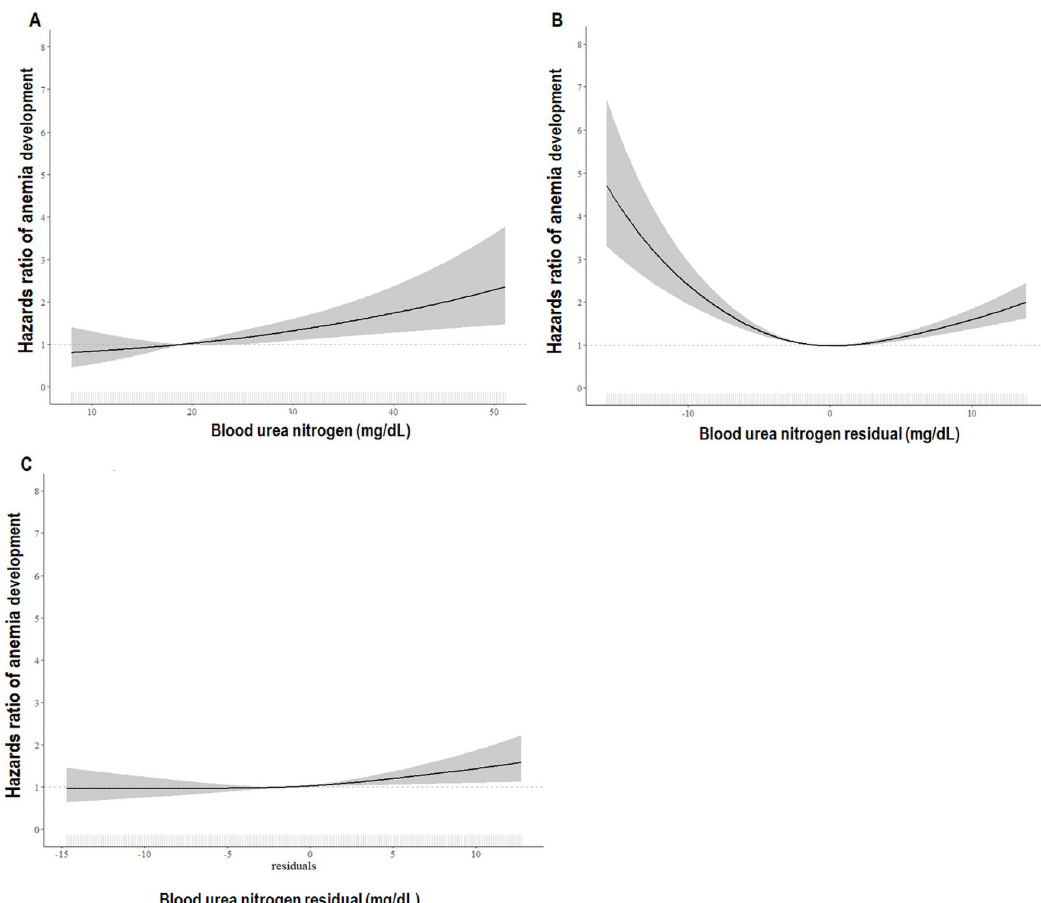
Fig 4. HRs of anemia development according to BUN and BUN residual. 4A. Multivariable-adjusted HRs of anemia development according to BUN. A restricted cubic spline curve adjusted by all confounding variables shows almost a linear positive relationship between BUN and the risk of anemia development. The adjusted HR of anemia development was significantly higher at BUN levels > 19 mg/dL. Adjusted for BUN, age, sex, smoking, SBP, DM, HTN, CCI, eGFR, log UPCR, WBC, platelet, log CRP, albumin, total cholesterol, log ferritin, log hepcidin, iron, and TSAT, use of iron replacement therapy, ESA, ACEi or ARB, statin, and diuretics. 4B. Unadjusted HRs of anemia development according to the BUN residual. Consistent with the Kaplan-Meier curve, the unadjusted cubic spline curve shows a U-shaped relationship between the BUN residual and HR of anemia development. 4C. Multivariable- adjusted HRs of anemia development according to the BUN residual. A restricted cubic spline curve adjusted by all confounding variables shows an almost linear positive relationship between the BUN residual and the risk of anemia development. The adjusted HR of anemia development was significantly higher at BUN residual levels > -1.3 mg/dL. Adjusted for BUN residual, age, sex, smoking, SBP, DM, HTN, CCI, eGFR, log UPCR, WBC, platelet, log CRP, albumin, total cholesterol, log ferritin, log hepcidin, iron, and TSAT, use of iron replacement therapy, ESA, ACEi or ARB, statin, and diuretics. The solid line represents the HRs of anemia, and the shaded areas indicate 95% CI. HR, hazard ratio; SBP, systolic blood pressure; DM, diabetes mellitus; HTN, hypertension; CCI, Charlson comorbidity index; eGFR, estimated glomerular filtration rate as determined by the CKD-EPI creatinine equation; BUN, blood urea nitrogen; WBC, white blood cell; UPCR, urinary protein-to-creatinine ratio; CRP, C-reactive protein; TSAT, transferrin saturation; ESA, erythropoiesis-stimulating agents; ACEi, angiotensin converting enzyme inhibitor, ARB, angiotensin II receptor blocker; CI, confidence